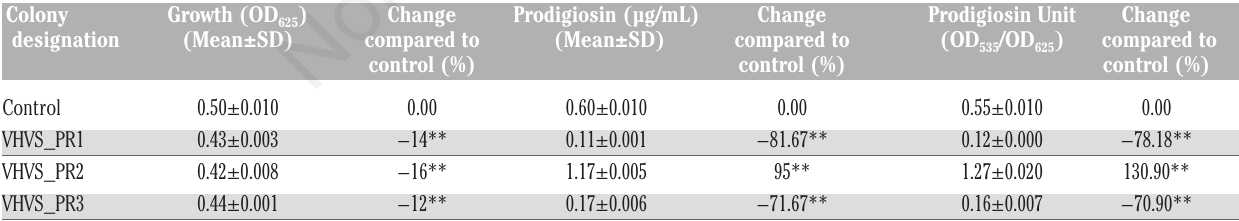
Table 4. Prodigiosin production in populations generated from the colonies obtained from prodigiosin overproducing broth. Colony